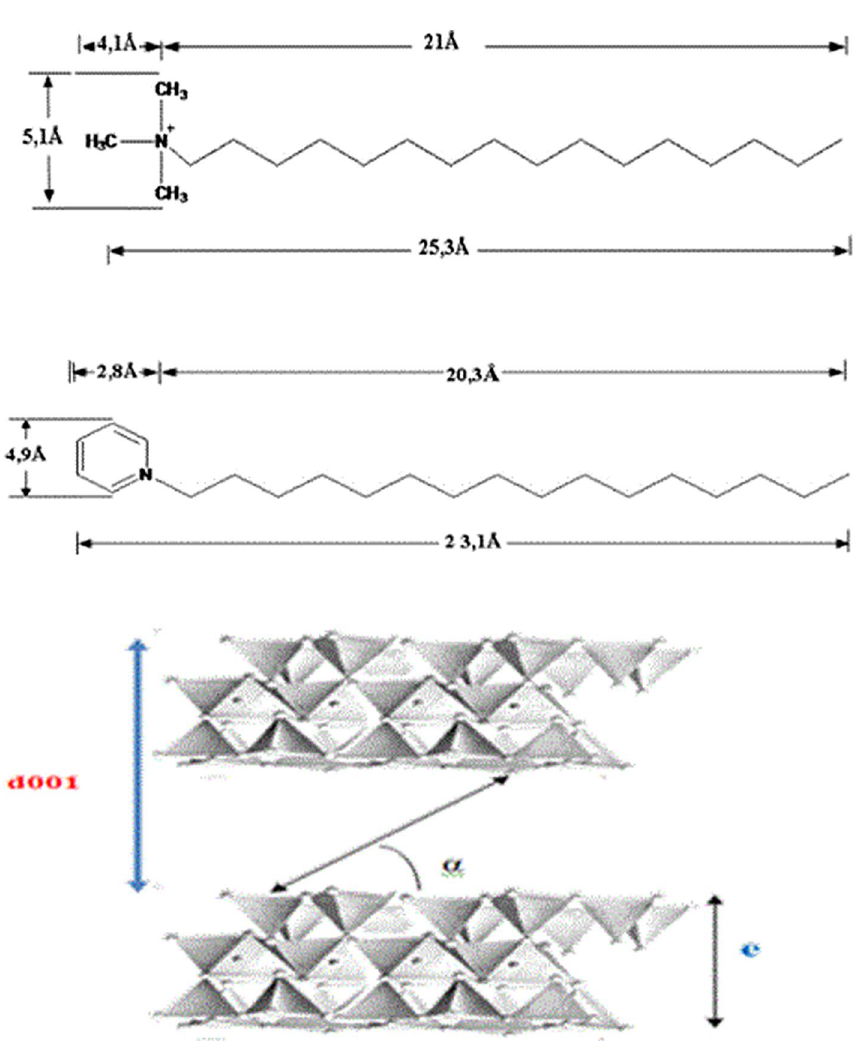
Fig. 6 Dimension of molecules (i) HDTMA+ and (ii) HDPy (Bors et al.